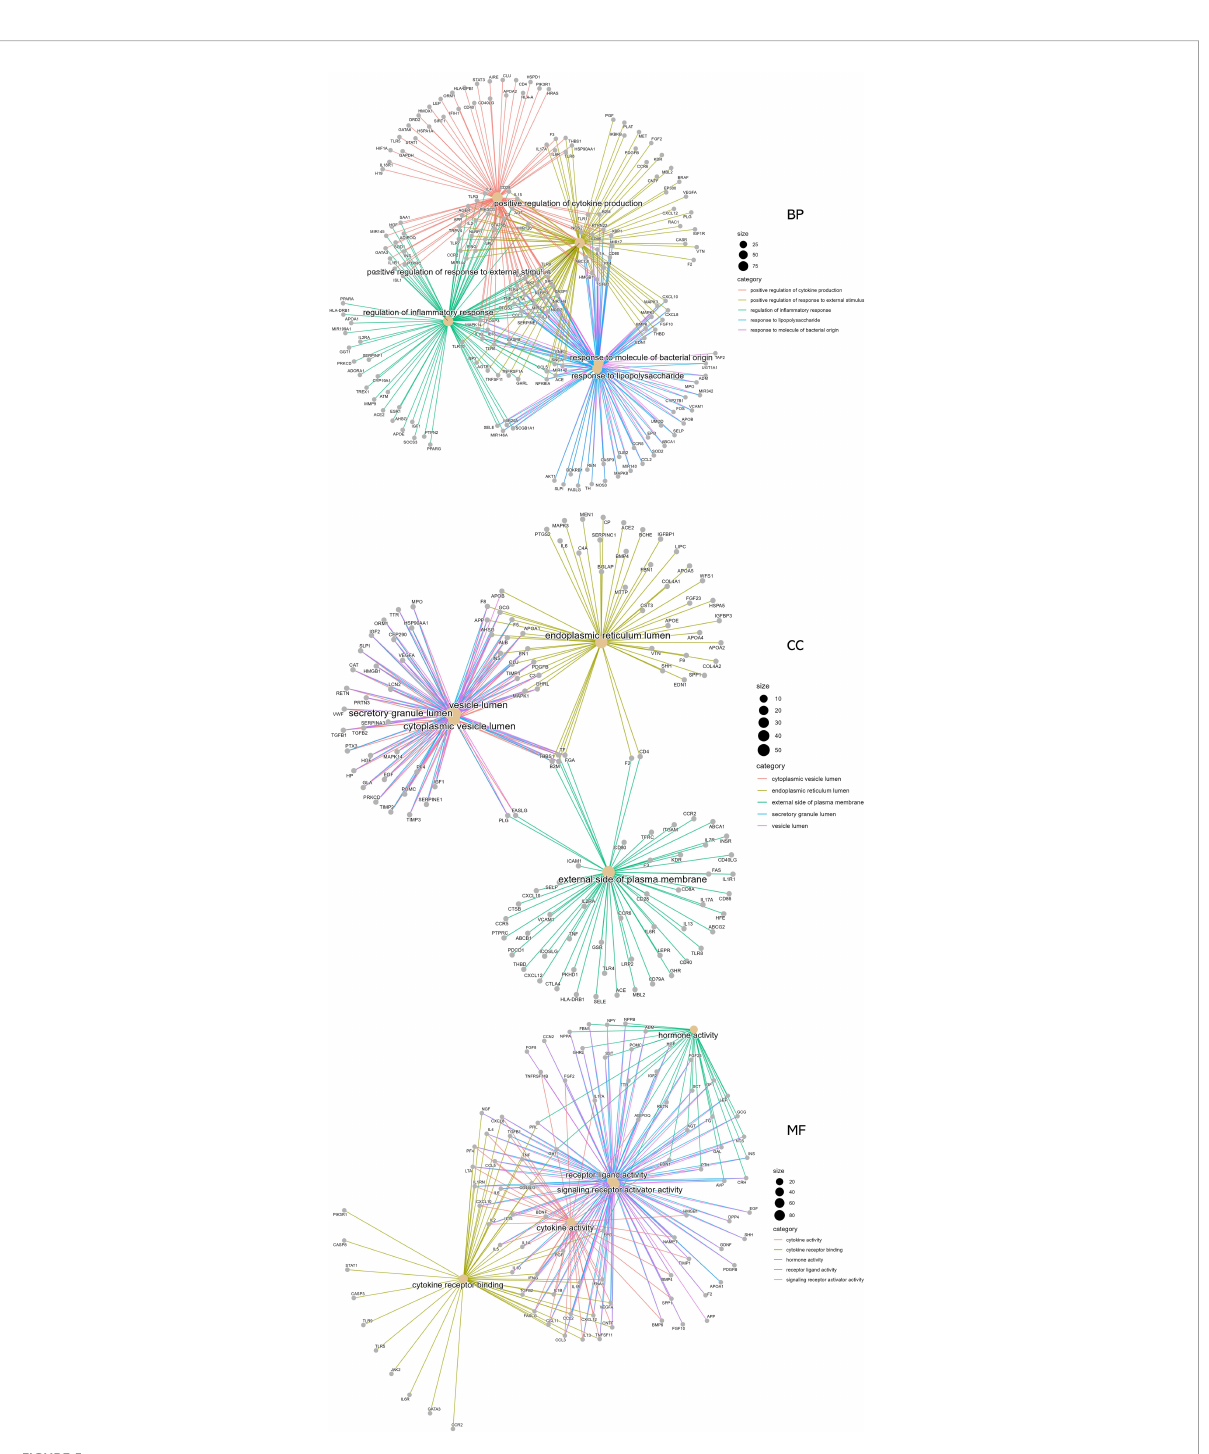
FIGURE 5 Relationships of the risk genes with the most signi fi cant biological process, cell component, and molecular function terms in Gene Ontology enrichment